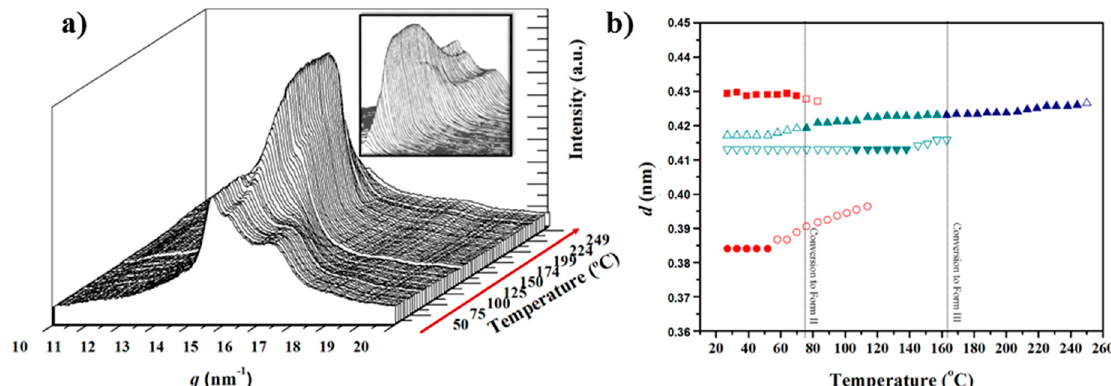
Figure 10. ( a ) Three-dimensional representation of WAXD profiles of a melt crystallized nylon 4 9 sample during the second heating (10 °C/min) from room temperature to fusion. Insets show a different orientation to clarify the temperature evolution of the main reflections. ( b ) Evolution of the spacings of the main reflections during the cooling run. Full and empty symbols indicate well-defined and intuited reflections, respectively. The temperatures at which structural transitions occur are indicated with vertical lines. Reflections corresponding to Forms I, II and III are indicated in red, green and blue, respectively.